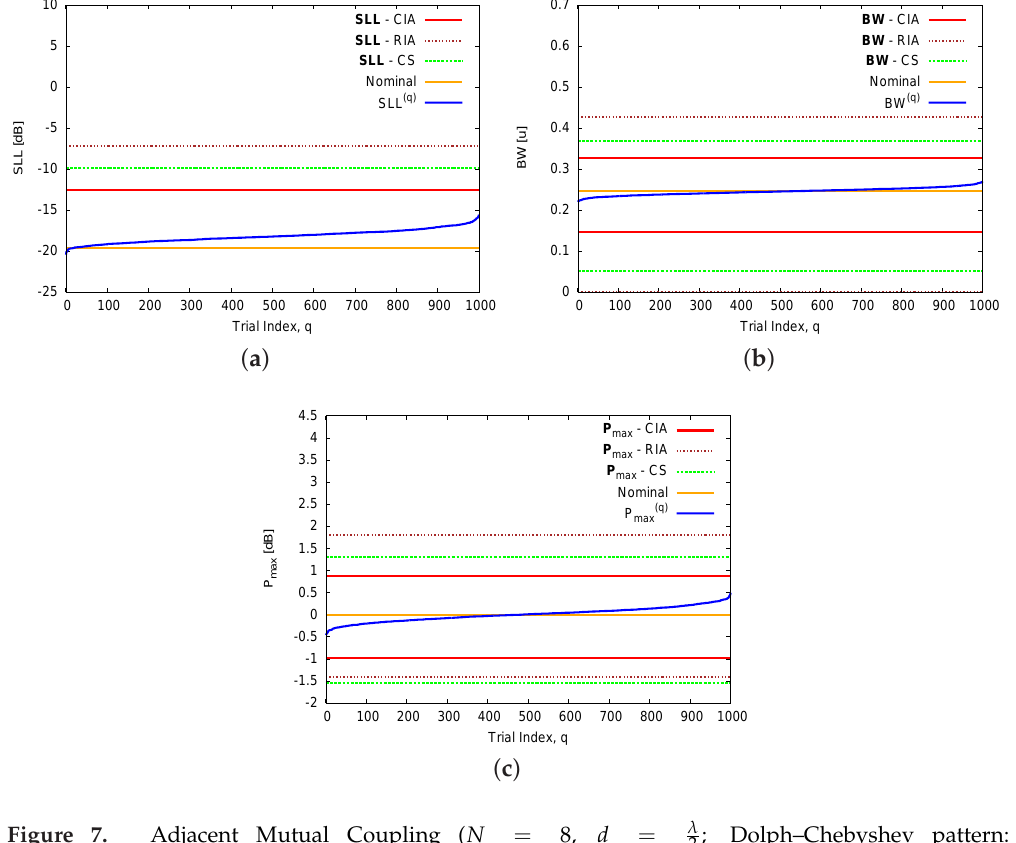
; Dolph–Chebyshev pattern: 2